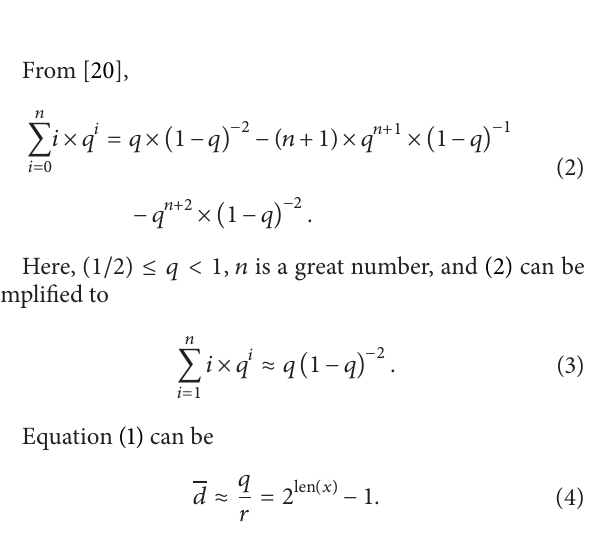
Figure 9: 𝑑 -jumping distance from right ( 1 < 𝑑 < (𝑛 − 𝑥)